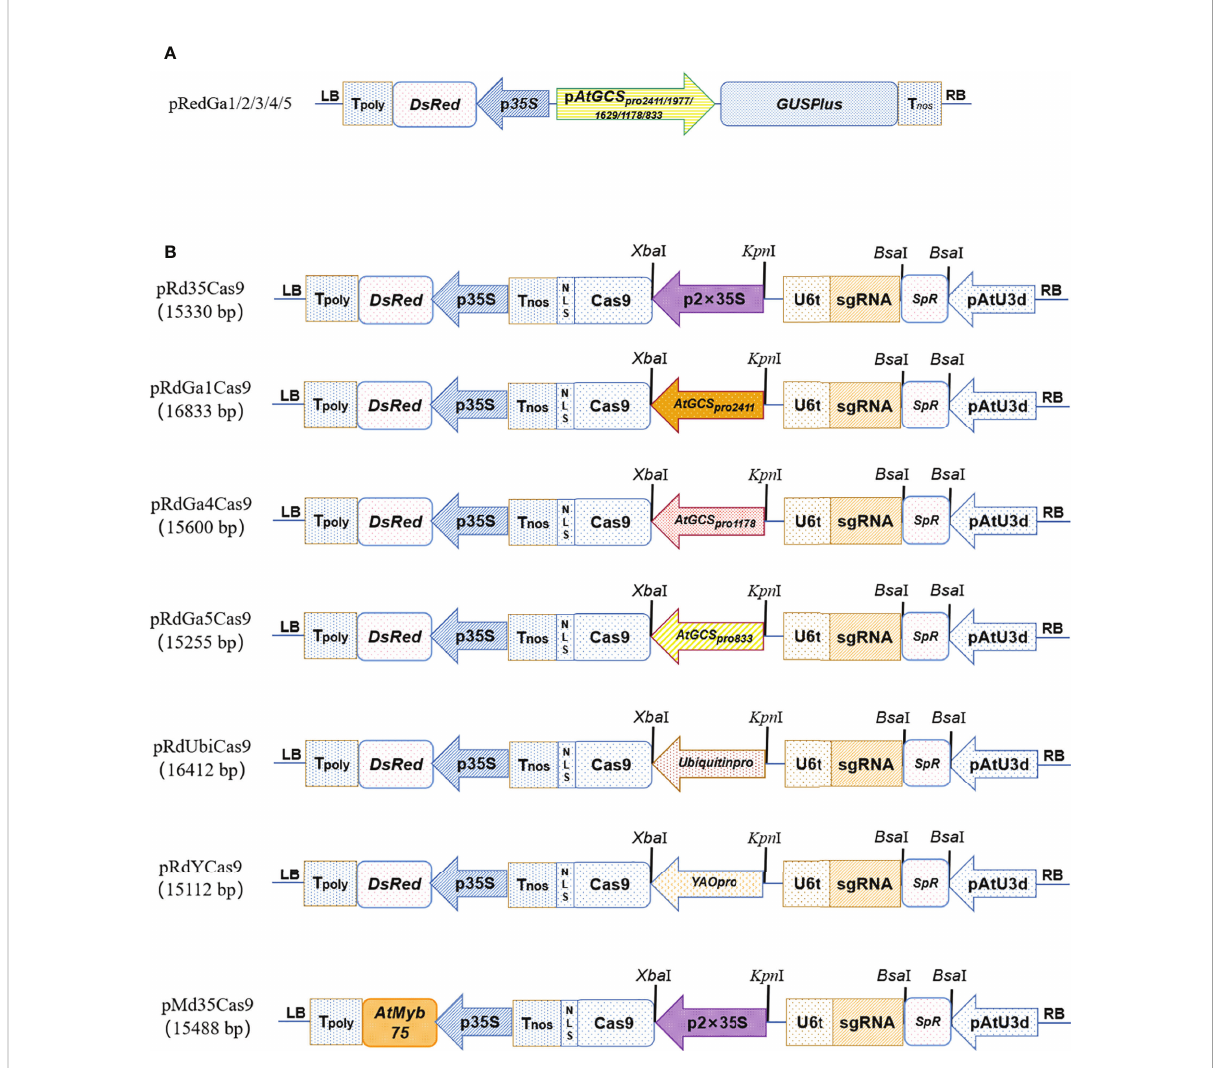
FIGURE 1 The schematic diagrams of vectors. The schematic diagrams of the pRedGa1 ( AtGCSpro 2411 :: GUSPlus ), pRedGa2 ( AtGCSpro 1977 :: GUSPlus ), pRedGa3 ( AtGCSpro 1629 :: GUSPlus ), pRedGa4 ( AtGCSpro 1178 :: GUSPlus ), and pRedGa5 ( AtGCSpro 833 :: GUSPlus ) (A) . CRISPR/Cas9-mediated gene knockout vector backbones pRd35Cas9, pRdGa1Cas9, pRdGa4Cas9, pRdGa5Cas9, pRdUbiCas9, pRdYCas9, and pMd35Cas9 (B)